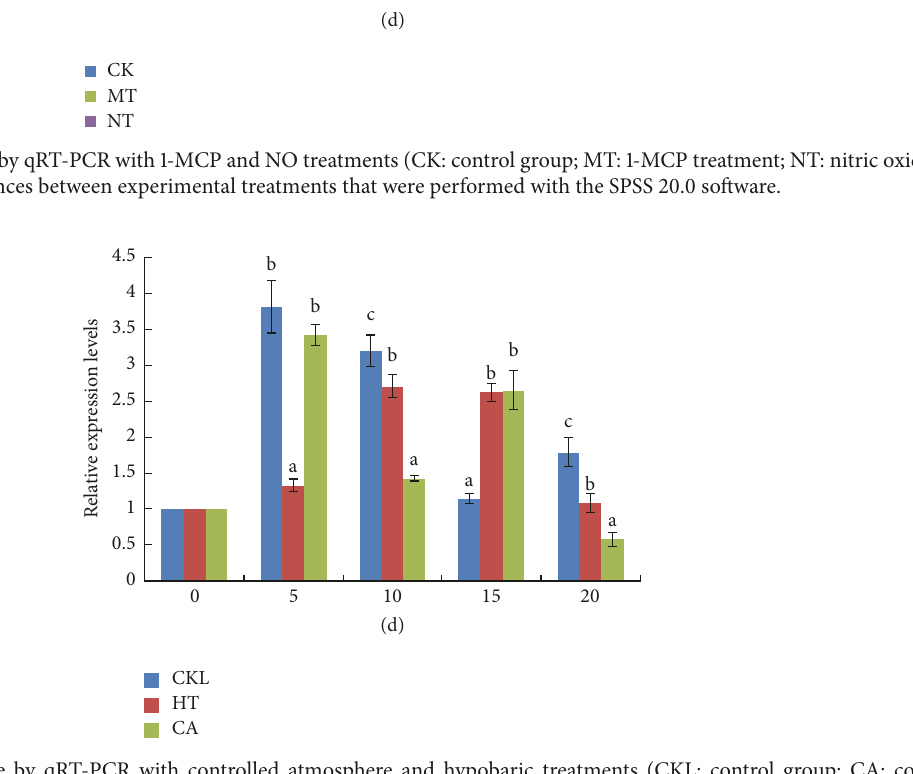
Figure 6: Expression profile by qRT-PCR with controlled atmosphere and hypobaric treatments (CKL: control group; CA: controlled atmosphere treatment; HT: hypobaric treatment). (a, b, and c) Differences between experimental treatments that were performed with the SPSS 20.0